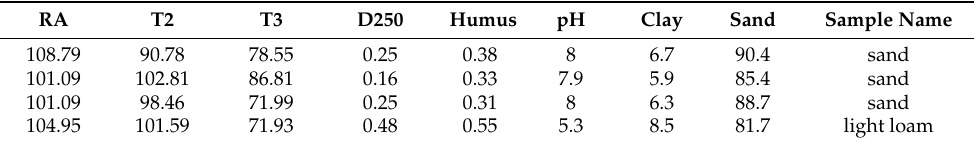
Table 2. An example of input